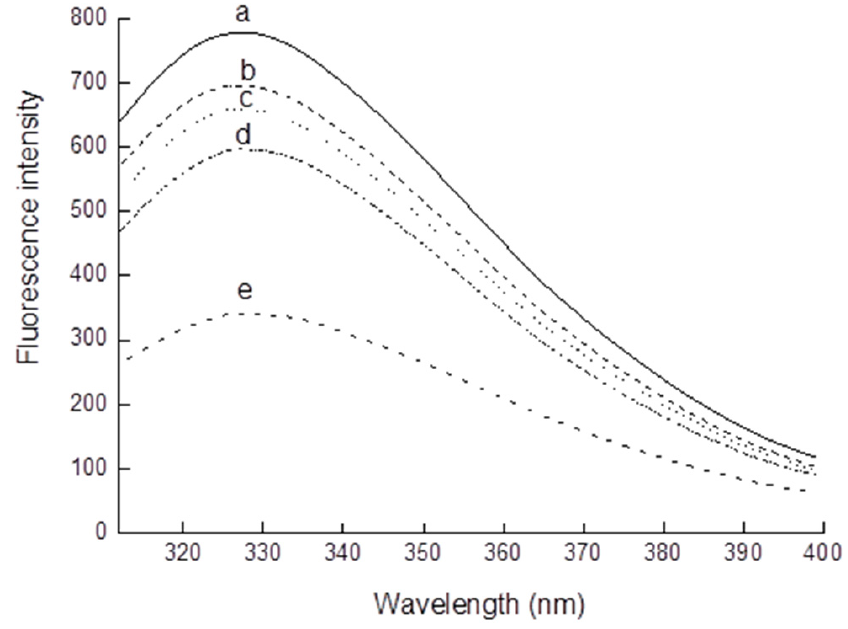
Figure 2. Intrinsic fluorescence of walnut protein incubated with different concentrations of MDA (a ‐ 0 mM; b ‐ 0.01 mM; c ‐ 0.1 mM; d ‐ 1 mM; and e ‐ 10 mM).